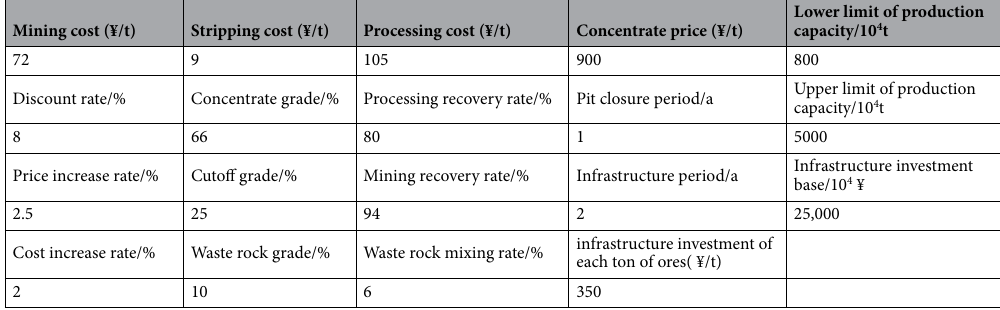
Table 1. The value of production scheduling optimization.